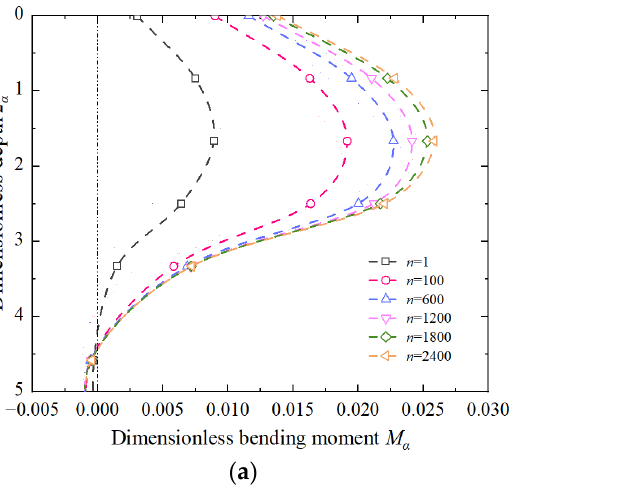
Figure 13. Dimensionless bending moment and subgrade reaction profiles under different cycle numbers. ( a ) bending moment profiles; ( b ) subgrade reaction profiles.